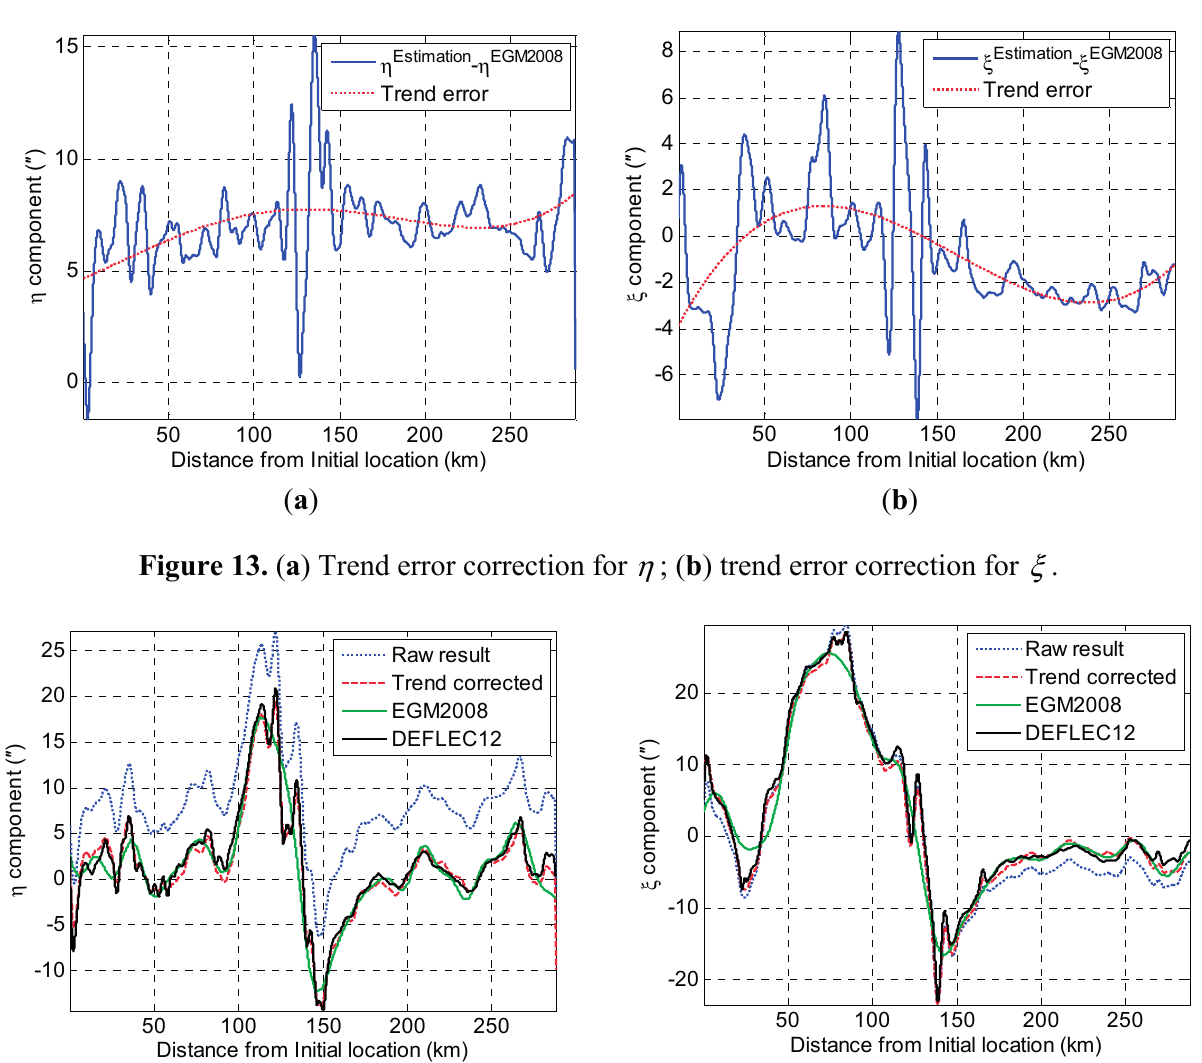
Figure 12. ( a ) Trend error extraction for η ; ( b ) trend error extraction for ξ .